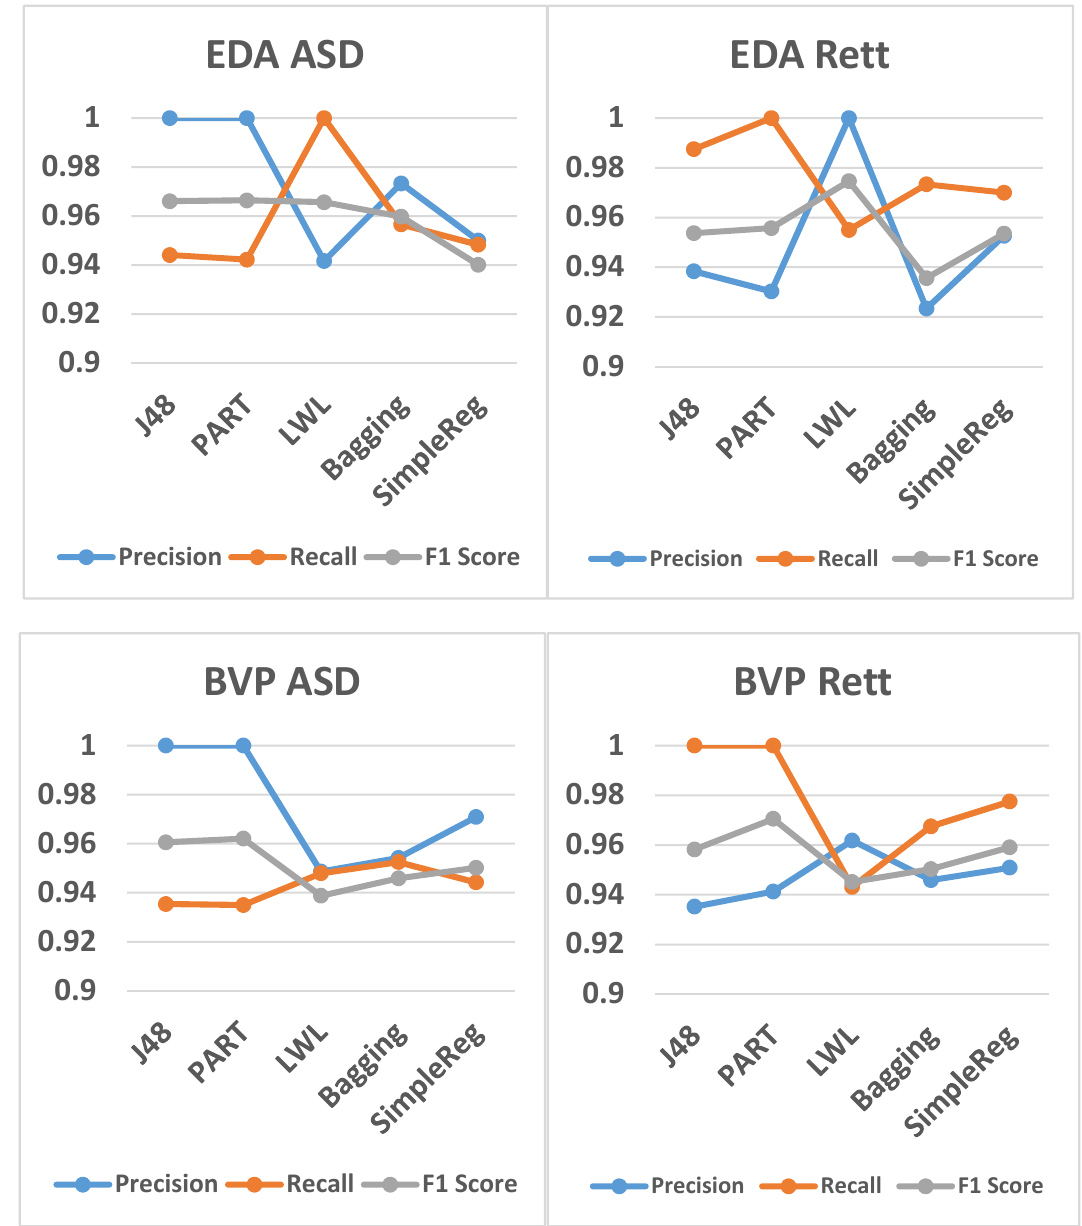
Figure 2. The 5 algorithms’ average precision (specificity), recall (sensitivity) and F1 score values for ASD vs. Rett participants when using EDA and BVP. Abbreviations and terminology: ASD (Autism Spectrum Disorder); BVP (Blood Volume Pulse); EDA (Electrodermal Activity); J48 (algorithm for building a decision tree); LWL (Locally Weighted Learning); PART (Class for generating a PART decision list); SimpleReg (Simple Logistic